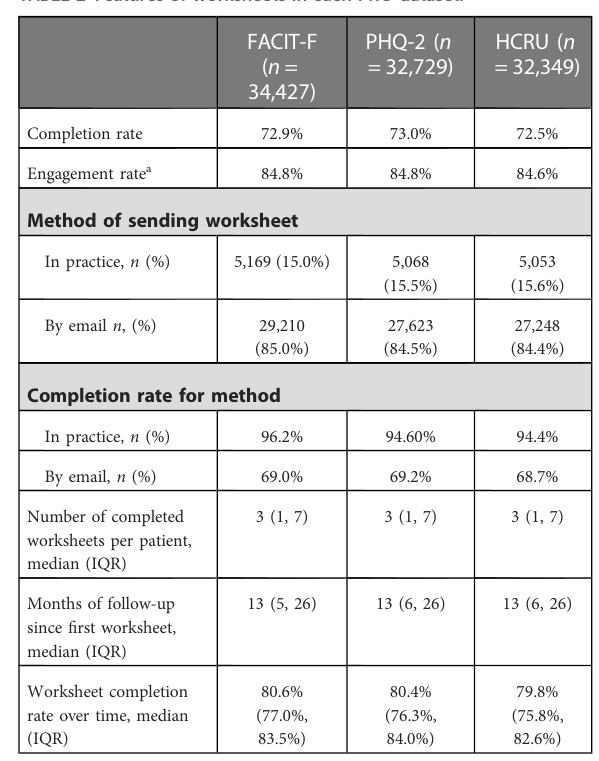
TABLE 2 Features of worksheets in each PRO